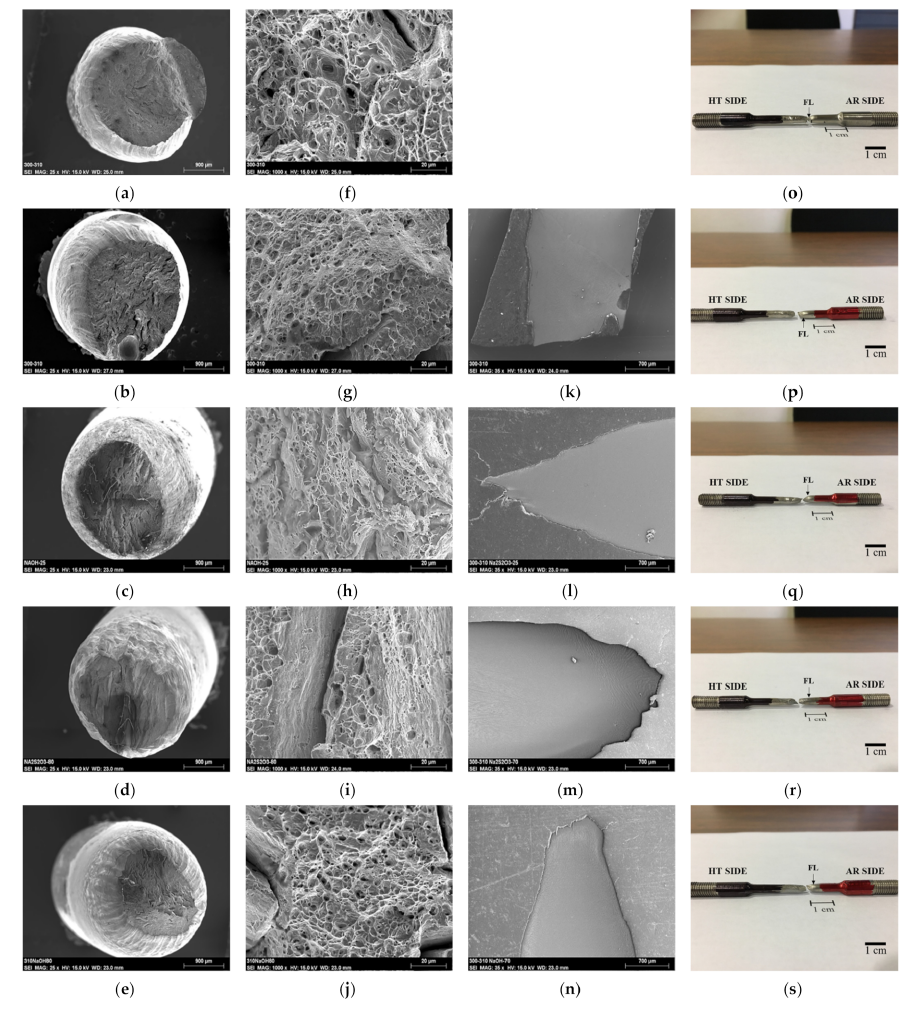
Figure 9. The SEM characterization of the fractured specimens for the ER310 welded joint in the inert and corrosive environments. ( a , f , o ) air; ( b , g , k , p ) Na 2 S 2 O 3 at RT; ( c , h , l , q ) NaOH at 25 ◦ C; ( d , i , m , r ) Na 2 S 2 O 3 at 80 ◦ C, and ( e , j , n , s ) NaOH at 80 ◦